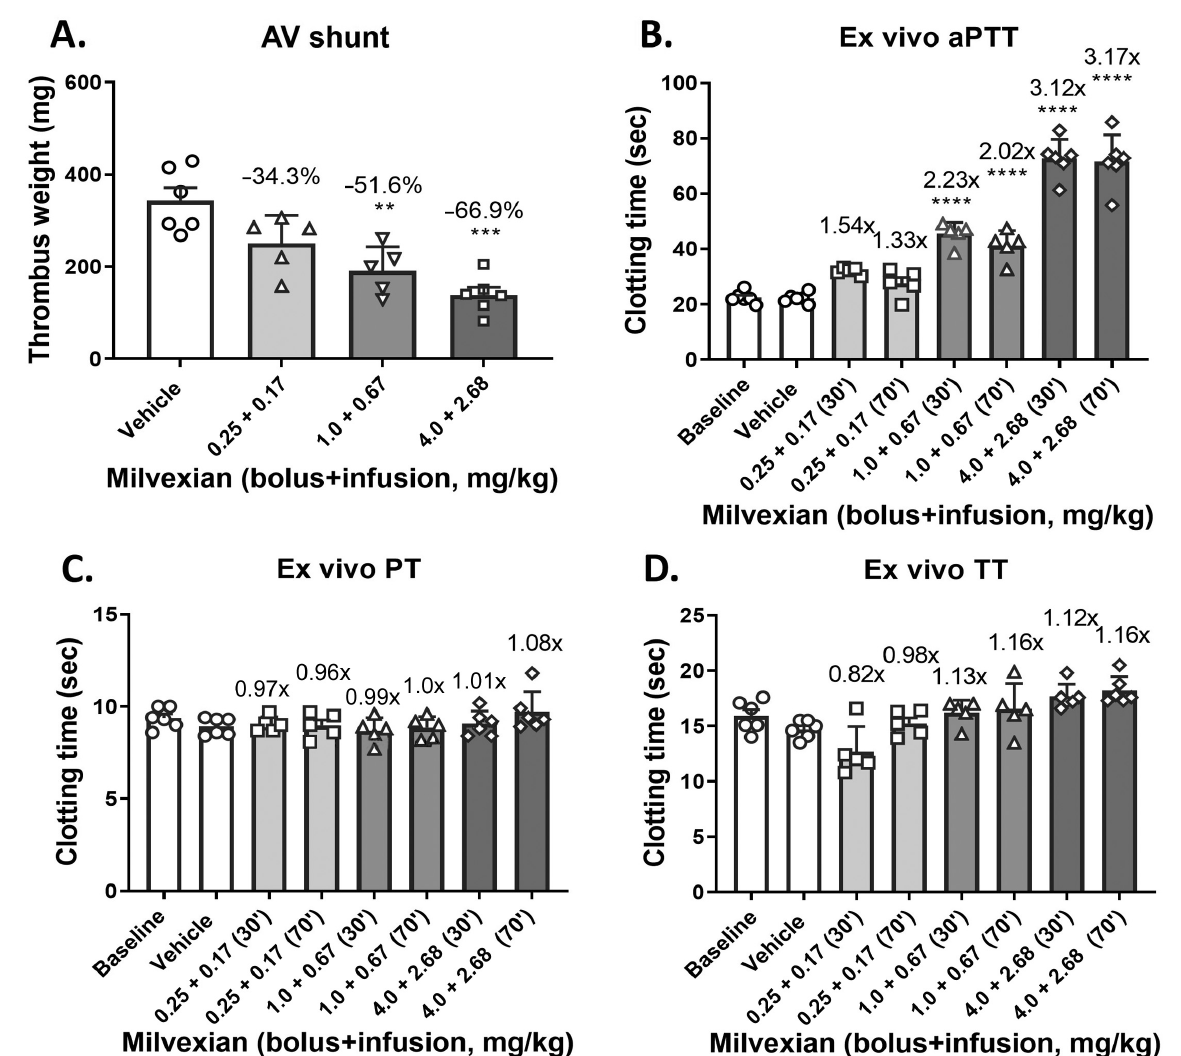
Fig. 1 Dose-dependent effects of milvexian on thrombus formation in the rabbit arteriovenous (AV) shunt model of thrombosis and ex vivo clotting. ( A ) Milvexian dose dependently reduced thrombus weight in the rabbit AV shunt model of thrombosis, with 34.3 (cid:1) 7.9, 51.6 (cid:1) 6.8, and 66.9 (cid:1) 4.8% inhibition versus vehicle, respectively, at doses of 0.25 þ 0.17, 1.0 þ 0.67, and 4.0 þ 2.68mg/kg. Plasma samples were taken immediately prior to (30minutes after infusion) and after (at 70minutes) the AV shunt thrombosis and subjected to the ex vivo analysis of ( B ) activated partial thromboplastin time (aPTT), ( C ) prothrombin time (PT), and ( D ) thrombin time (TT). Each symbol in ( A ) represents 1 animal. Fold changes are indicated against vehicle in ( B ) and ( C ). (cid:4)(cid:4) p < 0.01. (cid:4)(cid:4)(cid:4) p < 0.001. (cid:4)(cid:4)(cid:4)(cid:4) p < 0.0001. Analysis of variance (ANOVA) followed by Tukey ’ s